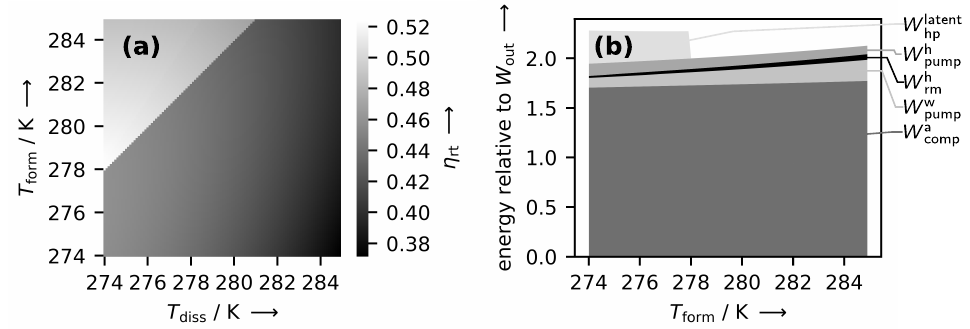
Figure 4. ( a ) Heat map of the RTE as a function of the formation and dissociation temperature. Bright spots indicate a high efficiency, dark spots a low efficiency. ( b ) Sum of process works, normalized to a net work output of 1.000kWh, as a function of formation temperature. The dissociation temperature is kept constant at 274K. Note that W a rm and W w rm are negligible on the scale of the graph and omitted for better